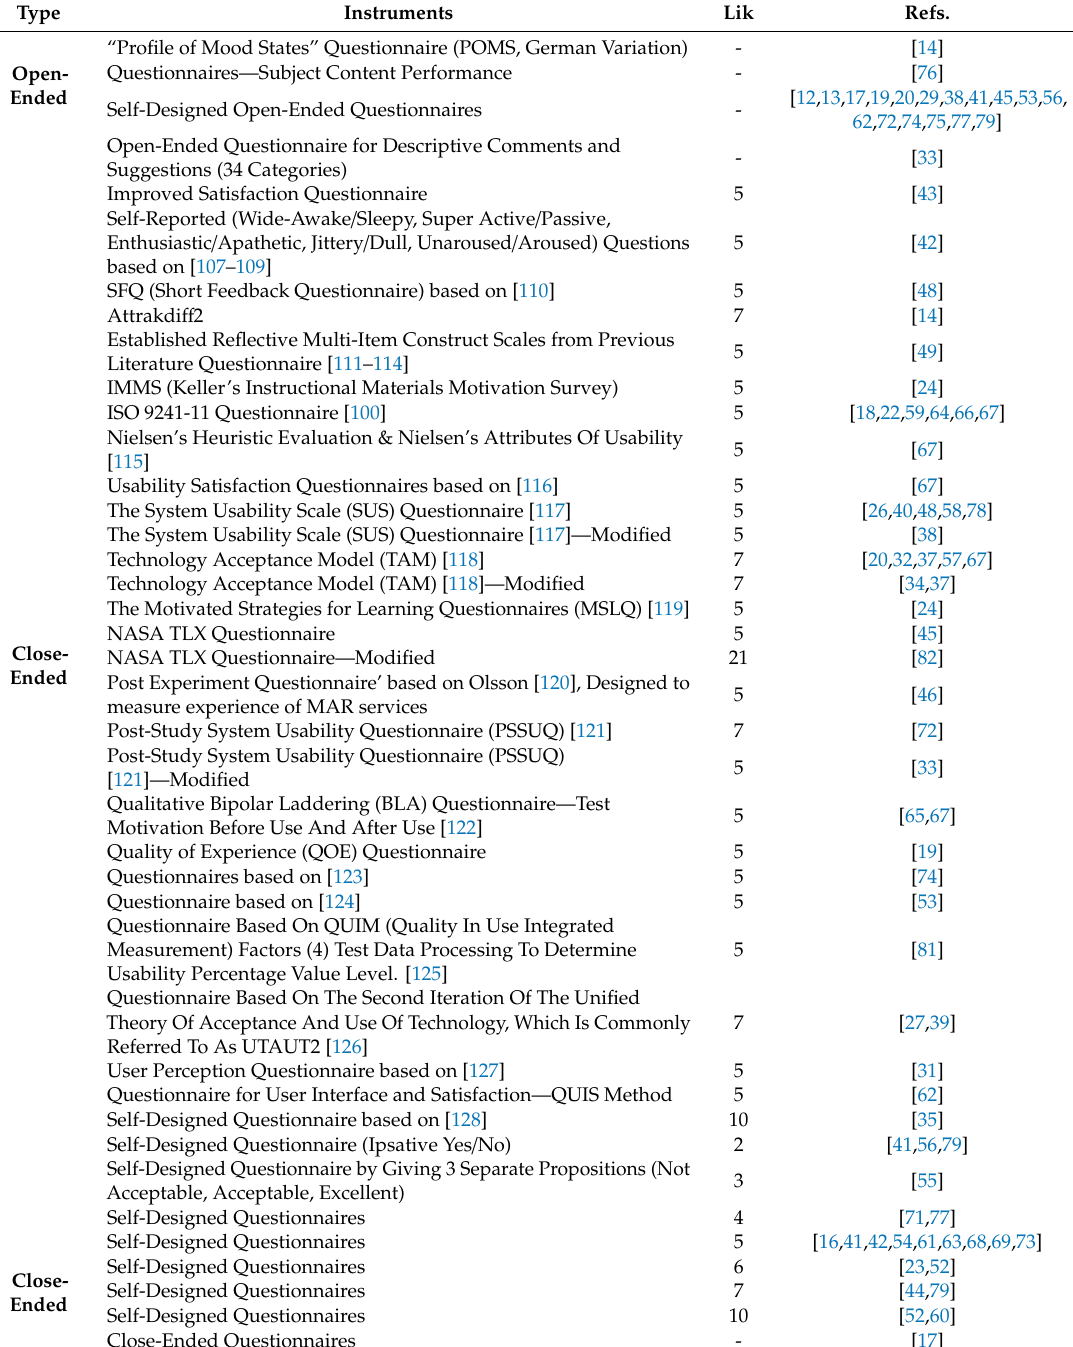
Table 12. Usability instruments (questionnaires).